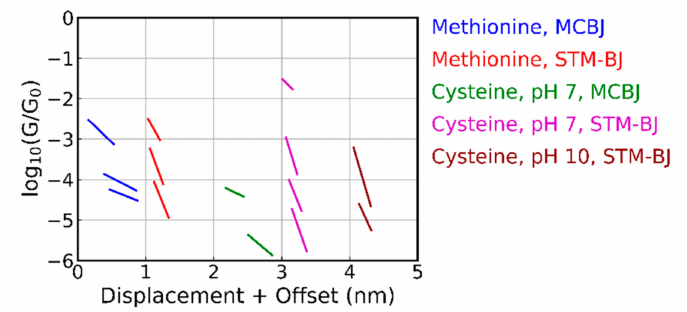
Figure 5. Comparison of the average conductance plateaus for methionine and cysteine obtained from the clustering analysis into 5 classes as measured by the two break-junction techniques. Plateaus (slanted line segments) are only shown if they are shorter than the amino acid and less steep than the tunneling slope. The plateau positions for subsequent molecules are o ff set by 1 nm in the horizontal displacement axis. The MCBJ data are the same as in Figure